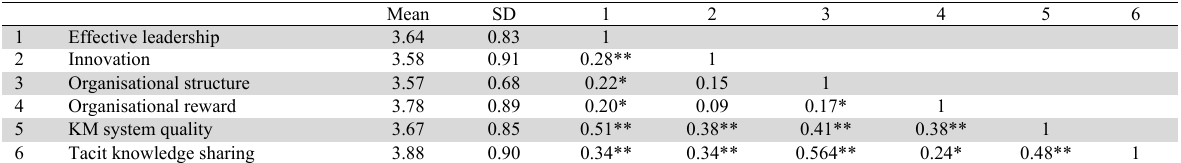
Correlations coefficient